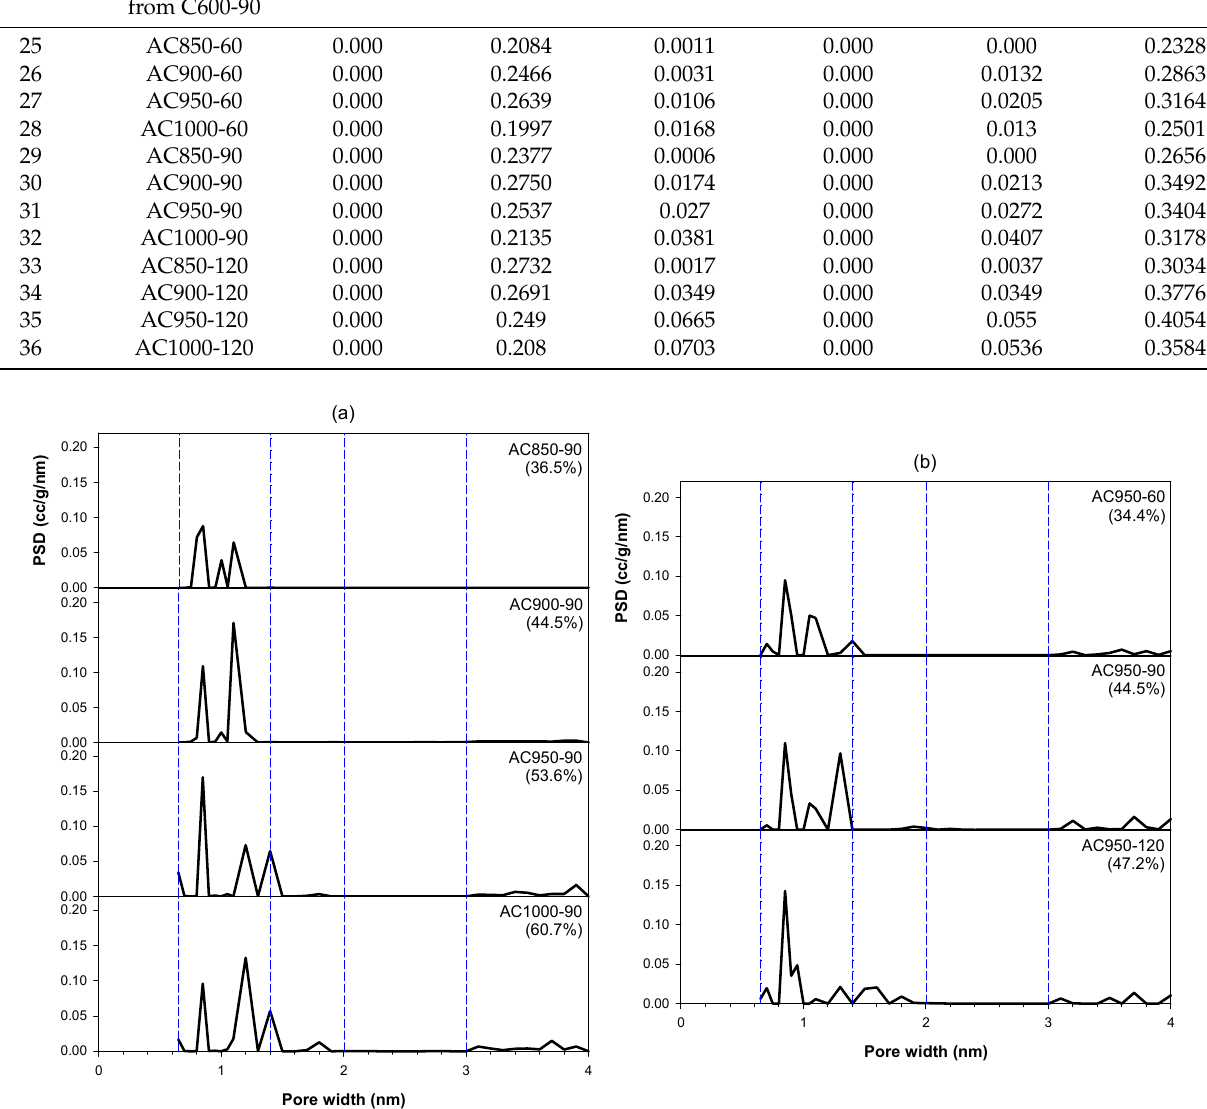
Figure 10. Effects of activation temperature and activation time on the pore size distribution of produced activated carbon for ( a ) char C400 - 90 and activation temperature of 90 min and ( b ) for char C500 - 90 and activation temperature of 950 °C .